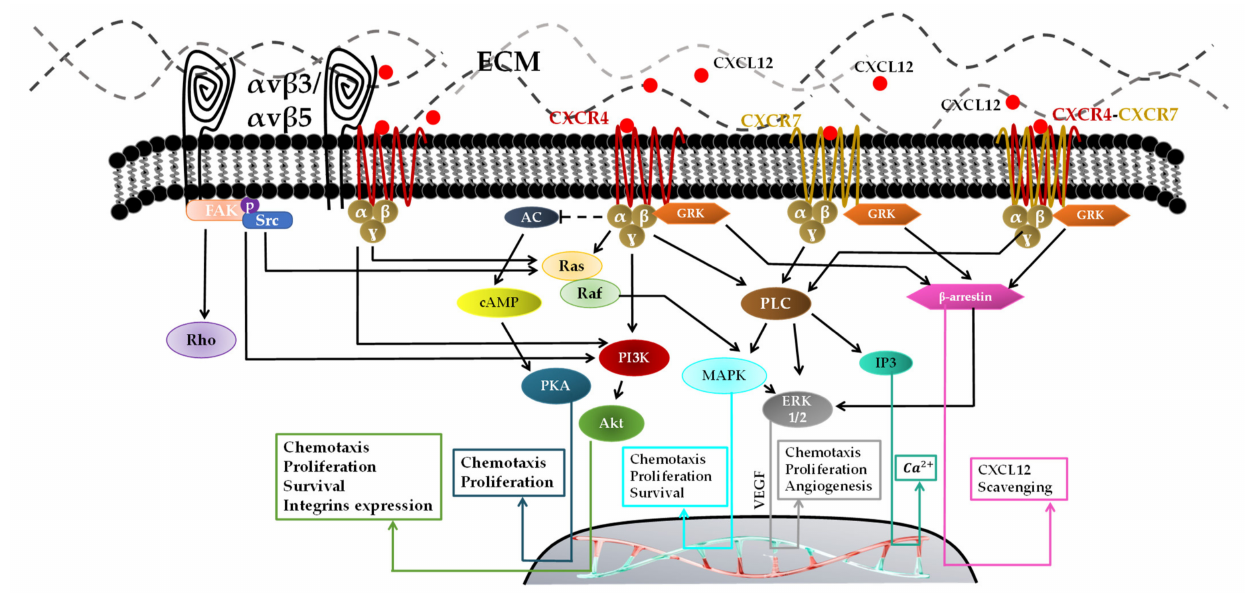
Figure 3. Schematic representation of different signaling pathways activated by CXCL12/CXCR4/CXCR7 axis and integrins. FAK: focal adhesion kinase; p: phosphorylation; Src: proto-oncogene tyrosine-protein kinase; cAMP: cyclic AMP, adenosine 3 (cid:48) ,5 (cid:48) -cyclic monophosphate; AC: adenylate cyclase; PKA: protein kinase A; PI3K: phosphoinositide 3 kinase; Akt: protein kinase B; MAPK: mitogen-activated protein kinase; PLC: phospholipase C; ERK: extracellular signal-regulated kinase; IP3: inositol trisphosphate; GRK: G-protein coupled receptor kinase; ECM: extracellular matrix; Ca 2+ : Calcium; CXCL12: CXC chemokine ligand 12; CXCR4: receptor CXC type 4; CXCR7: receptor CXC type 7; αβ ɣ : G protein complex; α v β 3: integrin alpha V and integrin beta 3; α v β 5: integrin alpha V and integrin beta 5; VEGF: vascular